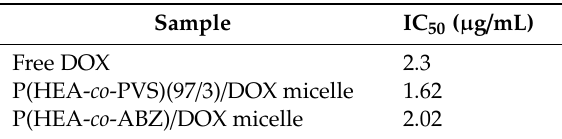
Figure 9. Viability of KB cells. Uppercase letters mean statistically significant differences in cell viability between the different samples when the doxorubicin concentration was the same. Lowercase letters represent statistically significant differences in cell viability between the same samples when the concentration of doxorubicin was different. Table 2. The half maximal inhibitory concentration (IC 50 ) values of free doxorubicin (DOX), P(HEA- co -PVS)(97/3)/DOX micelle, and P(HEA- co -ABZ)/DOX micelle for KB cells.